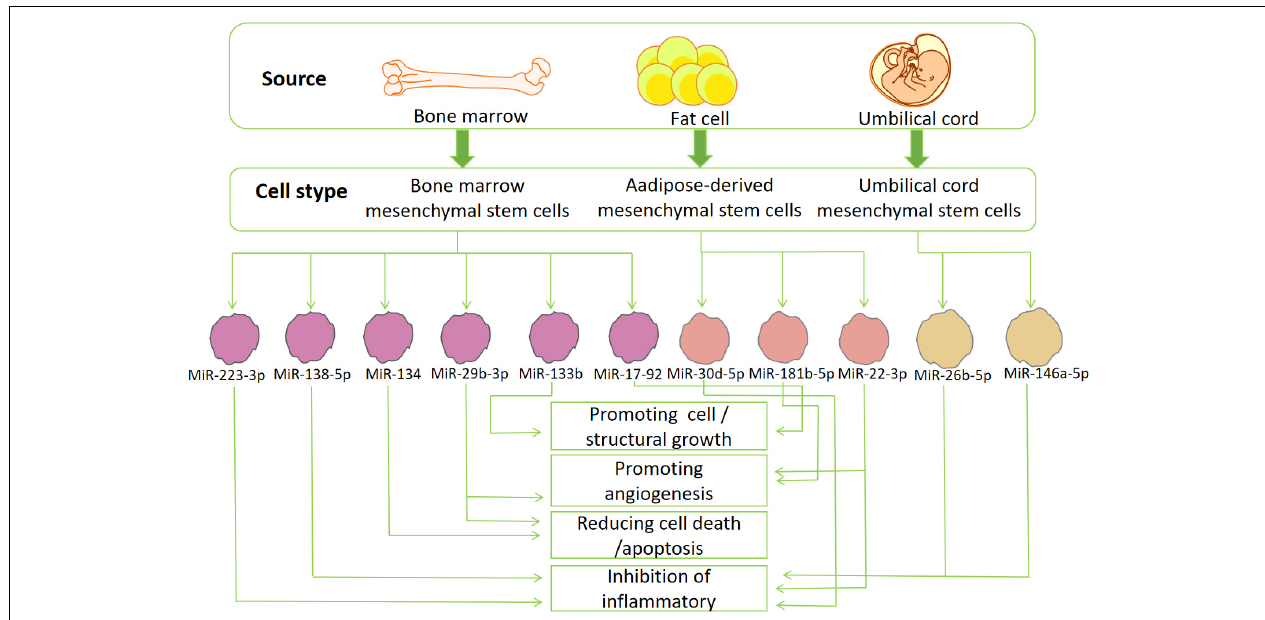
FIGURE 3 | The source and function of stem cells: exosomes derived from various mesenchymal stem cells (bone marrow-, adipose-tissue and umbilical cord mesenchymal stem cells) secrete miRNA that can participate in many pathological or physiological processes of ischemic stroke. These miRNAs can reduce inflammation, oxidative stress, cell death/apoptosis, or promote the formation of blood vessels, cells and structures.